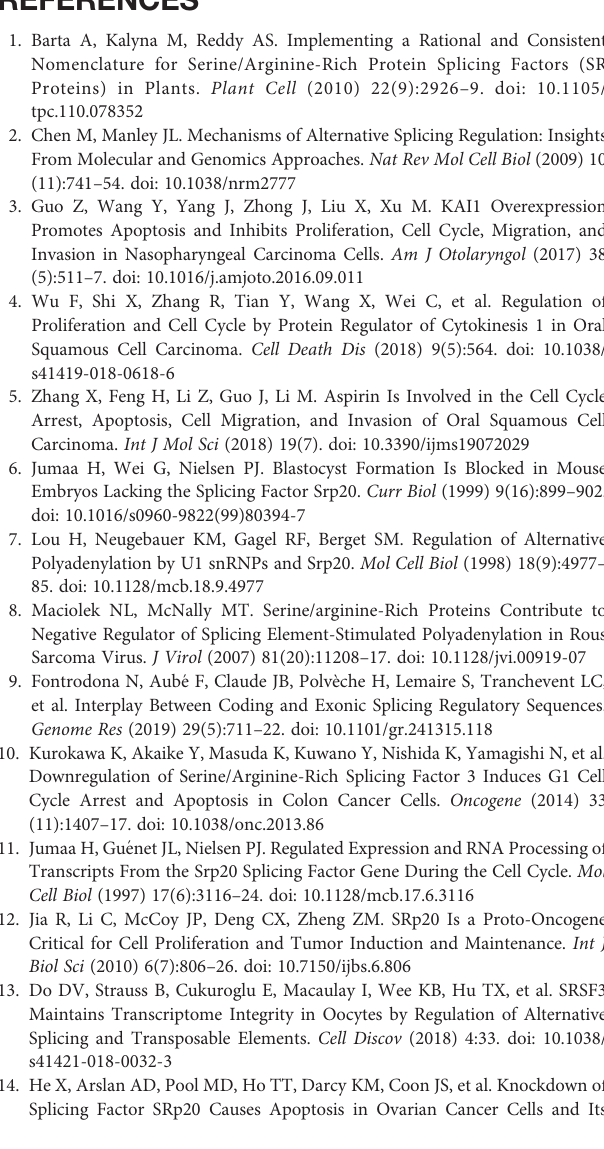
Supplementary Figure 1 | Estimate correlation between SRSF3 expression level and in fi ltration of various immune cells (B cells naive, CD4 + T cells, CD4 memory